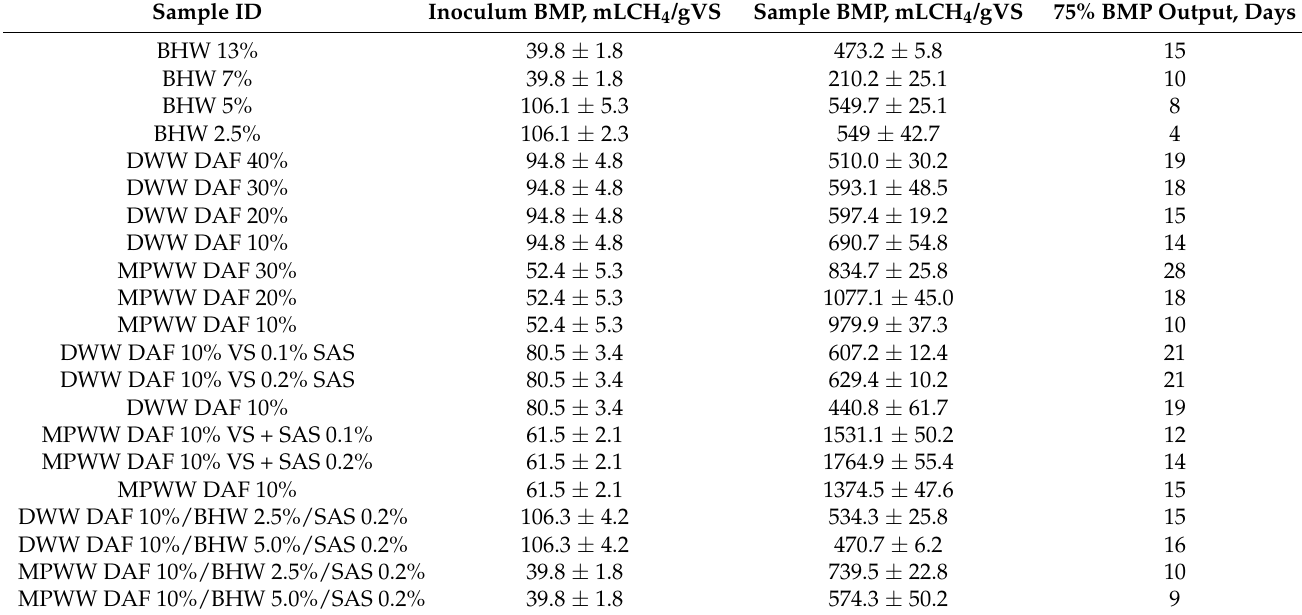
Table 4. Sample BMP potential and biomethane release velocity and inoculum from agricultural biogas station BMP when supplemented with meat production wastewater (MPWW) DAF sludge, together with biomass hydrolysis waste (BHW) co-digestion with anionic surfactant and dairy wastewater (DWW) DAF sludge with